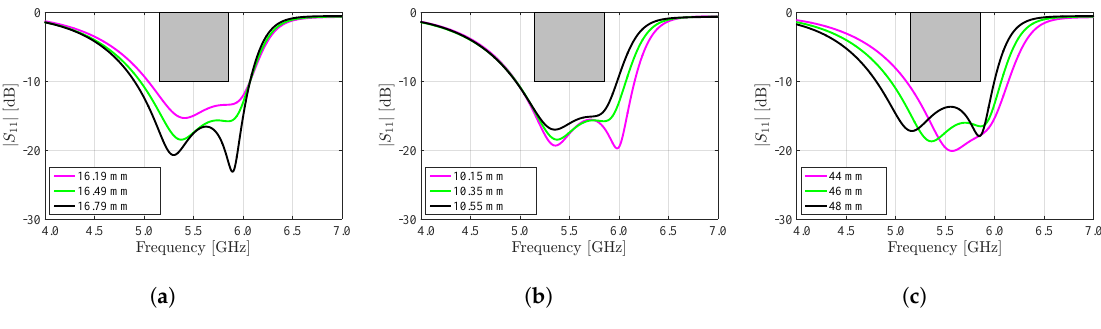
Figure 7. Simulated influence of cavity dimensions on the magnitude of the reflection coefficient | S 1,1 | of the antenna. ( a ) Influence of W a ; ( b ) Influence of W b ; ( c ) Influence of